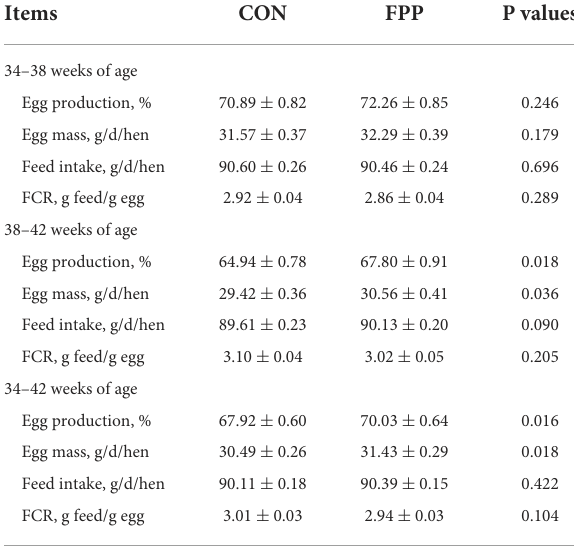
TABLE 3 Effects of FPP on the production performance of laying hens.